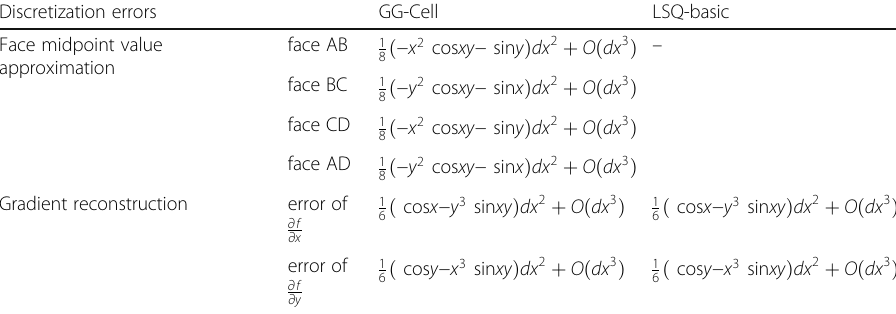
Table 2 Discretization errors of gradient reconstruction and face midpoint value approximation (quads.)